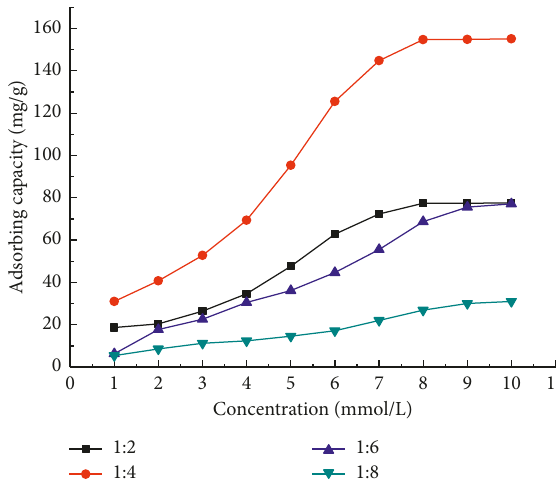
Figure 6: Effect of the ratio of template and monomer on adsorption.